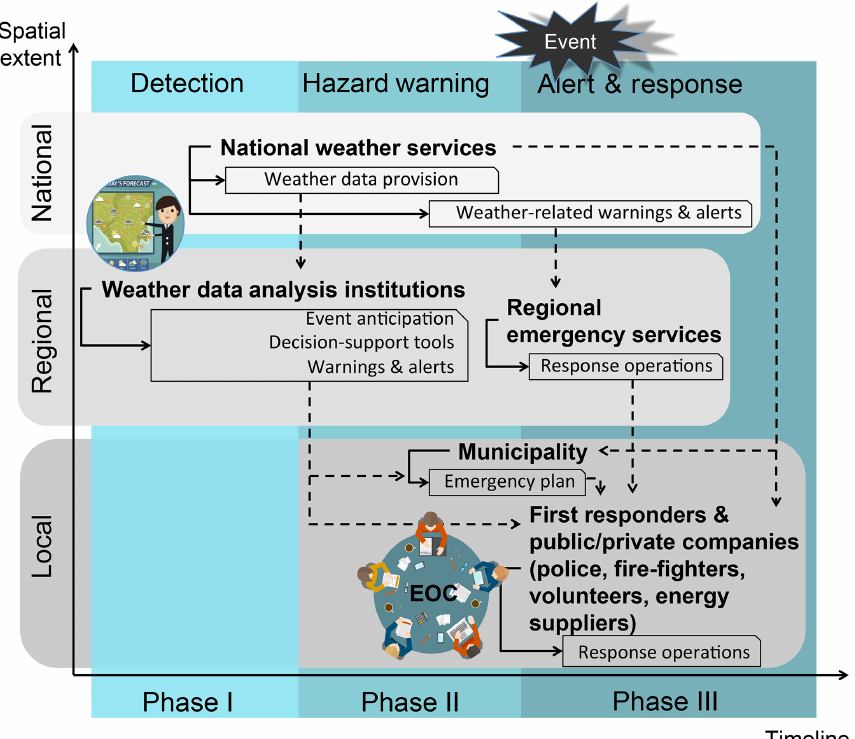
Figure 1. Conceptual framework of the weather-related European Warning Systems adopted for the design of ANYCaRE role-playing experiment. National, regional or local actors are framed within light, medium or dark grey rectangles. According to the warning/response phase in which they mainly operate, actors and their warning or emergency actions and decisions (snipped-corner rectangles) are presented inside the light (detection), medium (hazard warning) or dark-green boxes (emergency response). The dashed arrows illustrate the flow of information among national, regional and local actors. Adapted after Müller et al.